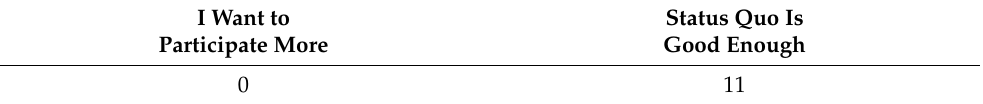
Table 3. Willingness of residents regarding participation in HRC activities (excluding HRC members).